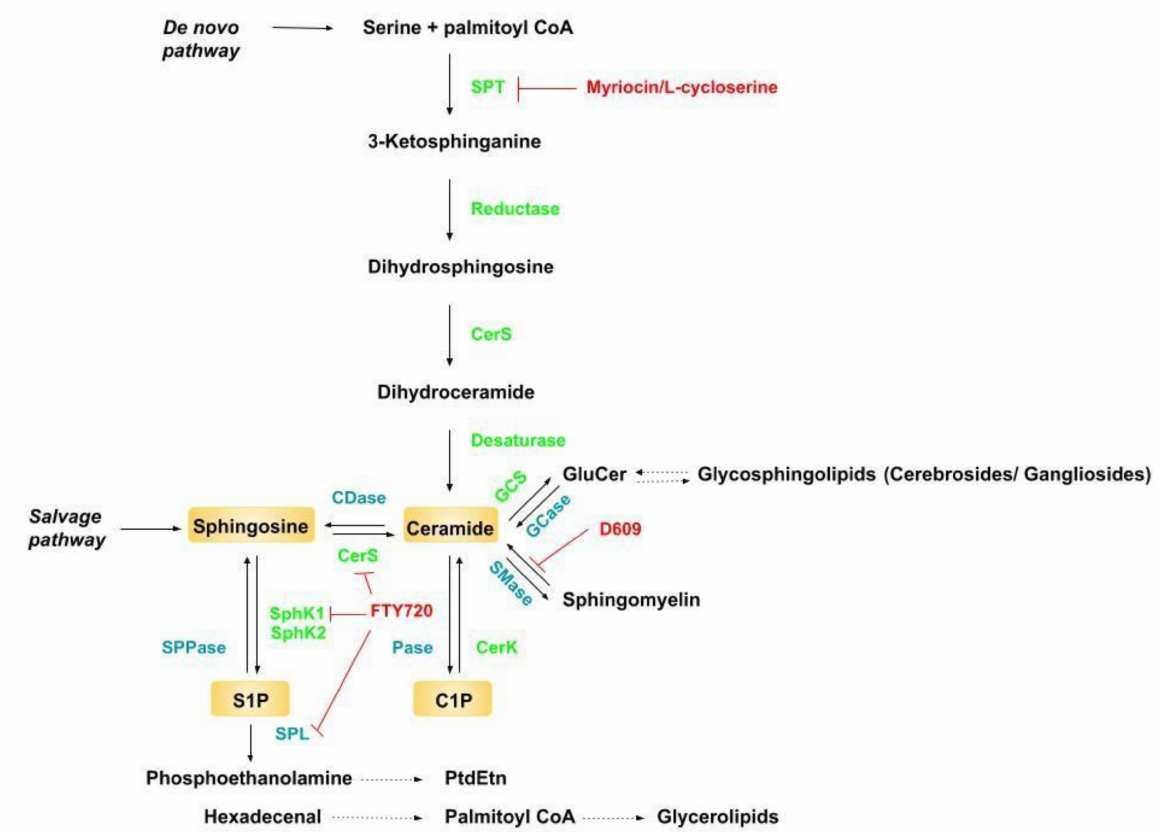
Figure 1. Sphingolipid general pathway. Enzymes are presented in green and drugs commonly used in the studies reviewed here are presented in red. CDase—Ceramidase; CerK—Ceramide Kinase; CerS—Ceramide Synthase; C1P— Ceramide-1-Phosphate; D609—Tricyclodecan-9-yl-Xanthogenate; FTY720—Fingolimod; GCase—Glucosylceramidase; GCS—Glucosylceramide Synthase; Pase—Phosphatase; PtdEtn—Phosphatidylethanolamine; SMase—Sphingomyelinase; SphK—Sphingosine Kinase (1 and 2); SPL—Sphingosine-1-phosphate Liase; SPPase—Sphingosine Phosphate Phosphatase; SPT—Serine Palmitoil-CoA Transferase;